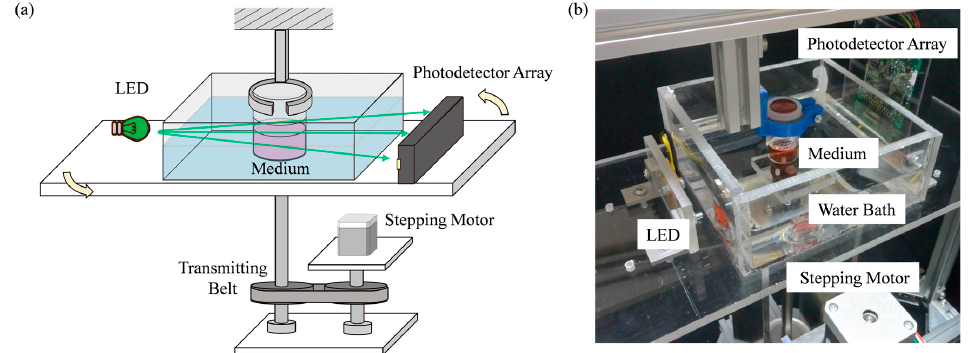
Figure 2. The experimental device. ( a ) A schematic drawing of the system and ( b ) a photo of the system.